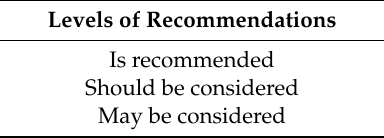
Table A2. Levels of Recommendations for Guidelines for a sustainable